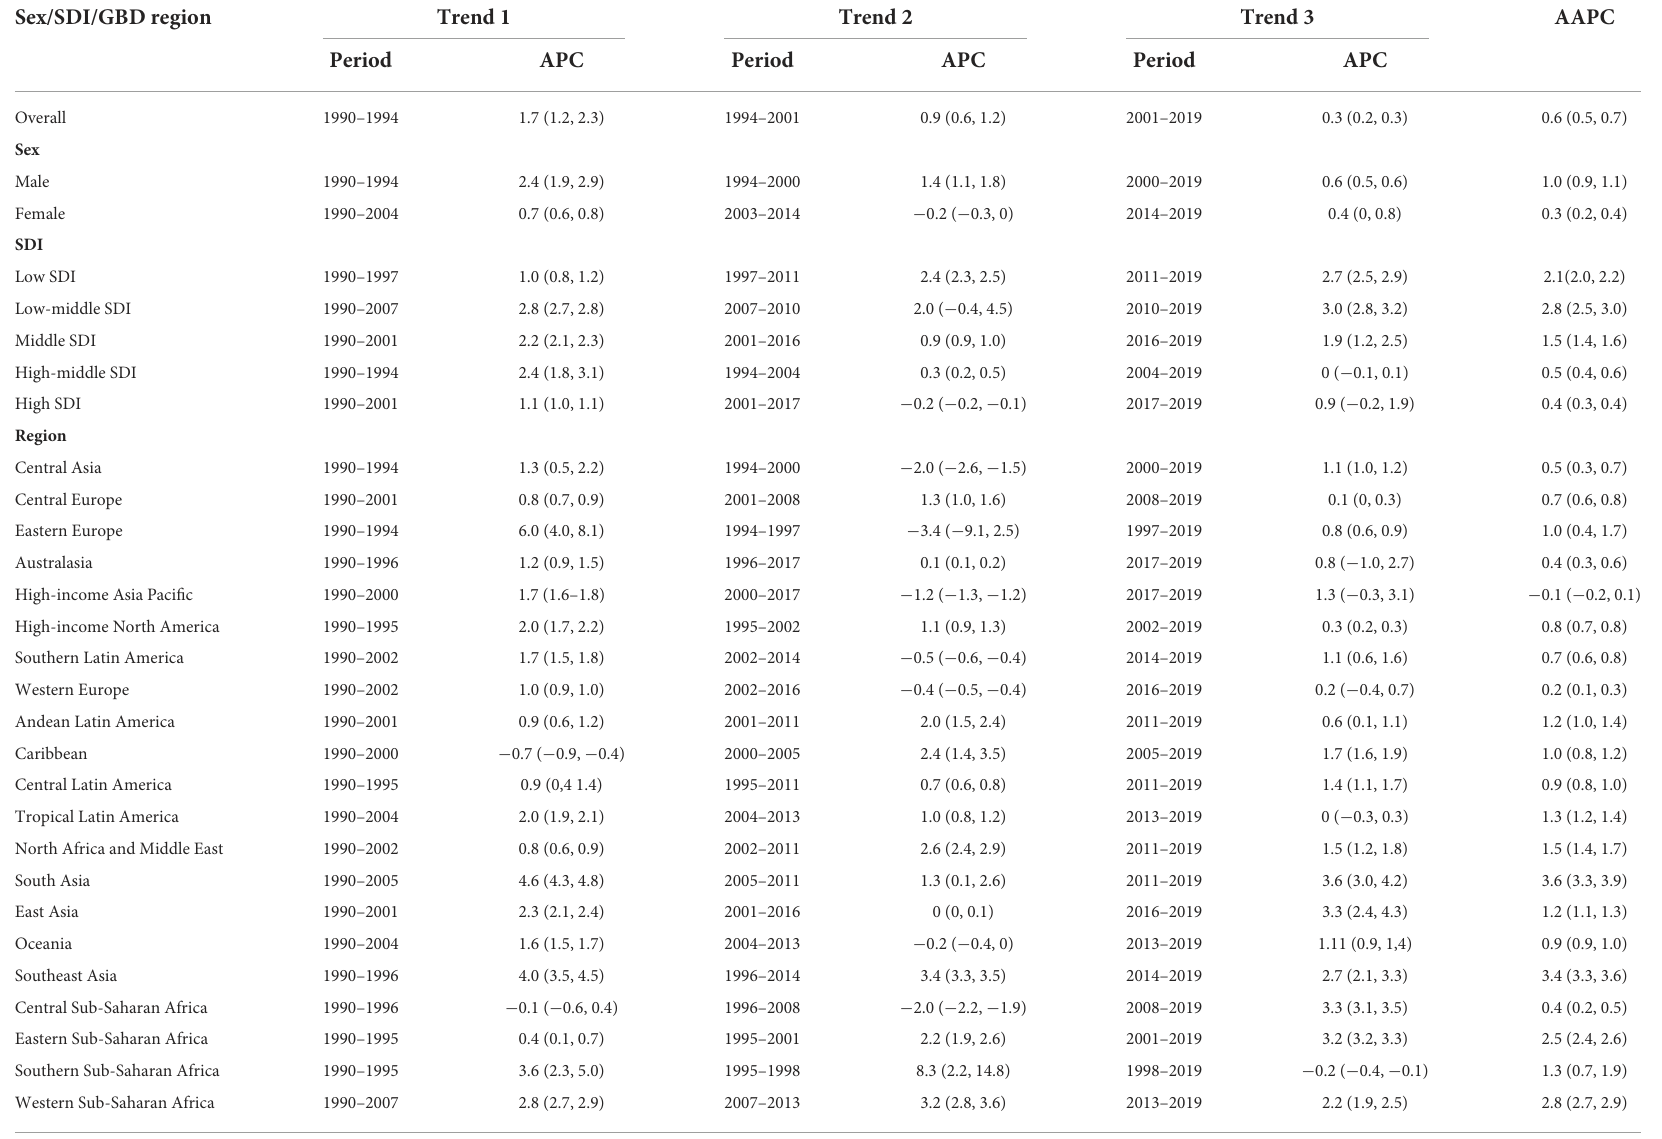
TABLE 2 Time trend analysis of ASMR for cancer attributable to high body mass index from 1990 to 2019 by sex, SDI, and GBD region. Sex/SDI/GBD region Trend 1 Trend 2 Trend 3 AAPC Period APC Period APC Period